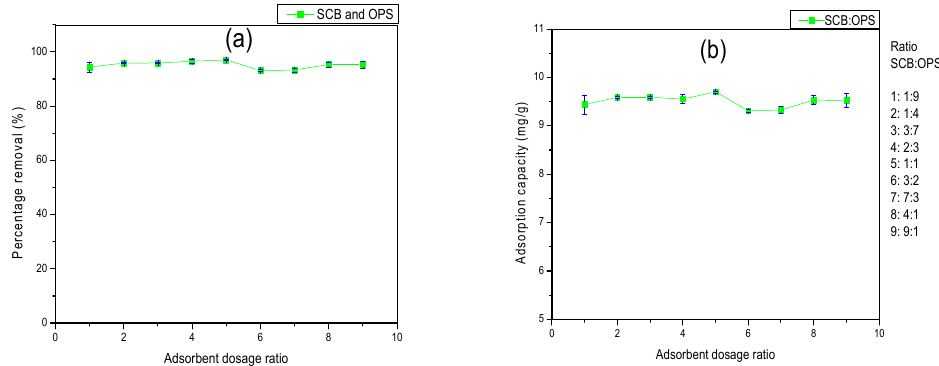
Figure 12. Effect of adsorption capacity: ( a ) 20 mg/L Pb(II) percentage removal and ( b ) 20 mg/L Pb(II) adsorption capacity.